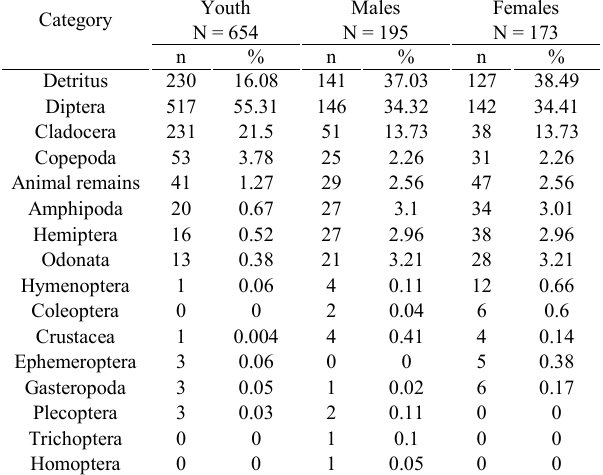
Table 1. Occurrence of food components (N = number sampled; n = number of organisms that have the category, 5 occurrence rate) by sex.